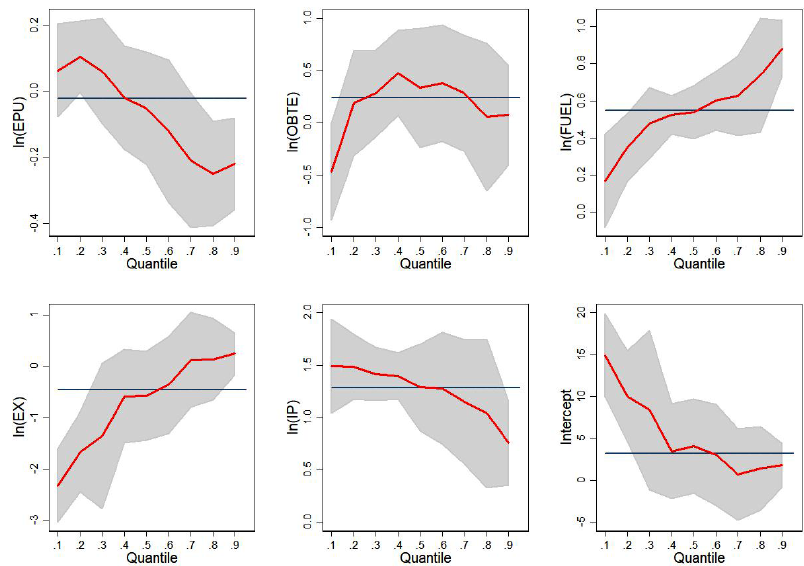
Figure 4. Model 1: Plot of the QR coefficient of the